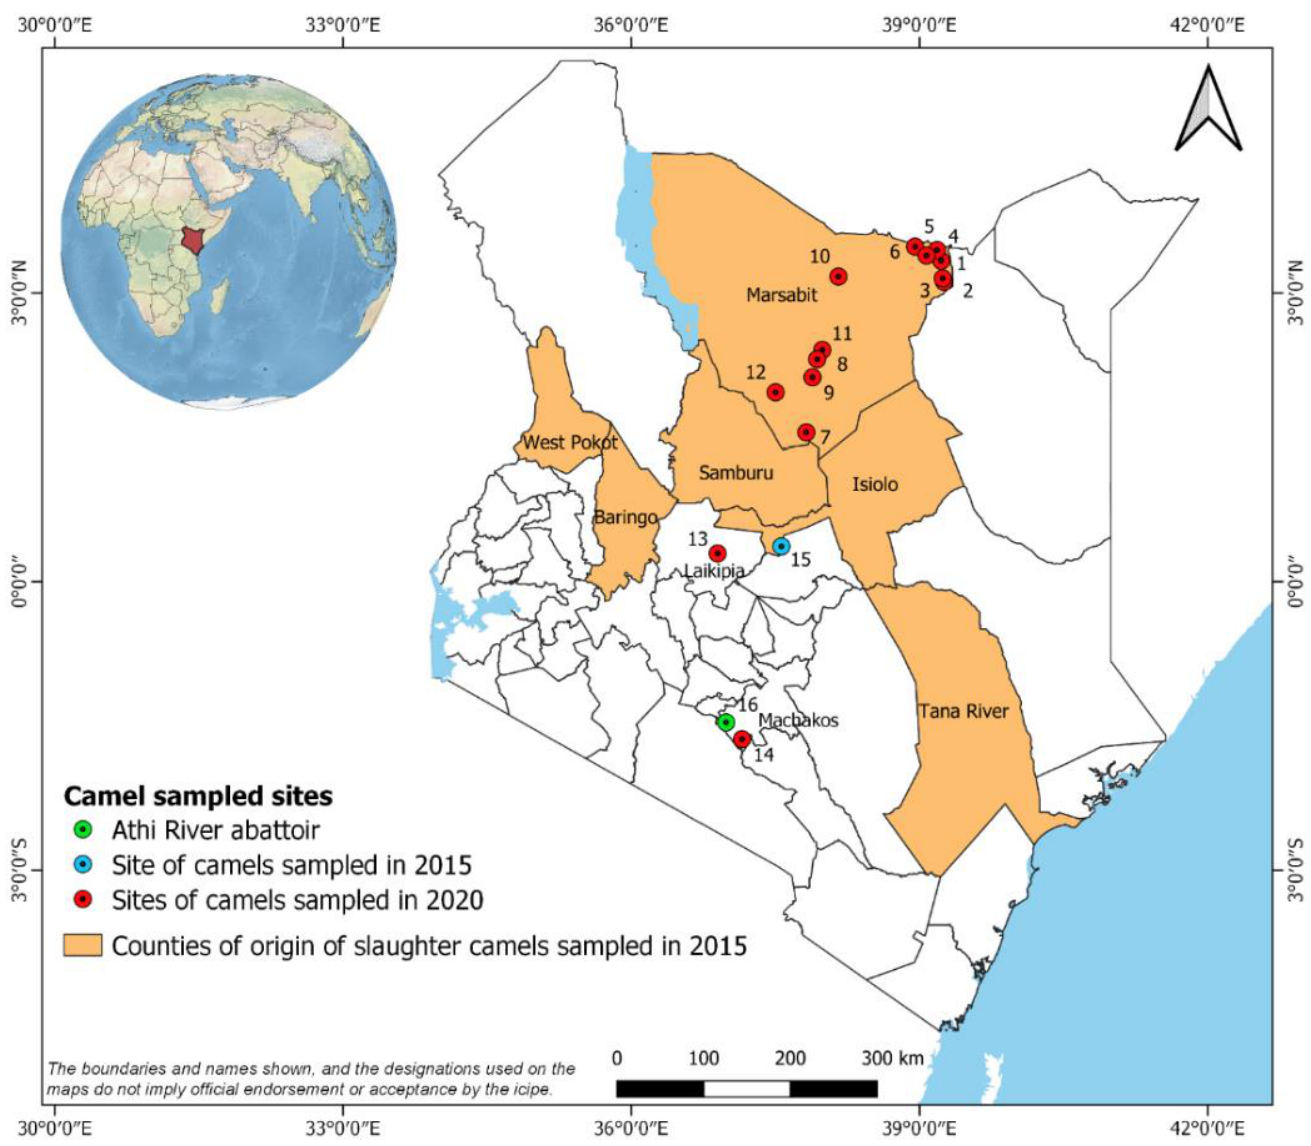
Figure 1. Map of Kenya showing sampling sites in Marsabit, Laikipia, and Machakos Counties visited in 2020 (red spots), sampling site in Isiolo County visited in 2015 (blue spot) and site of the Athi River abattoir (green spot). Counties of origin of camels sampled in 2015 are shaded in brown. Locations of numbered sites are listed in Tables S1 and S2.